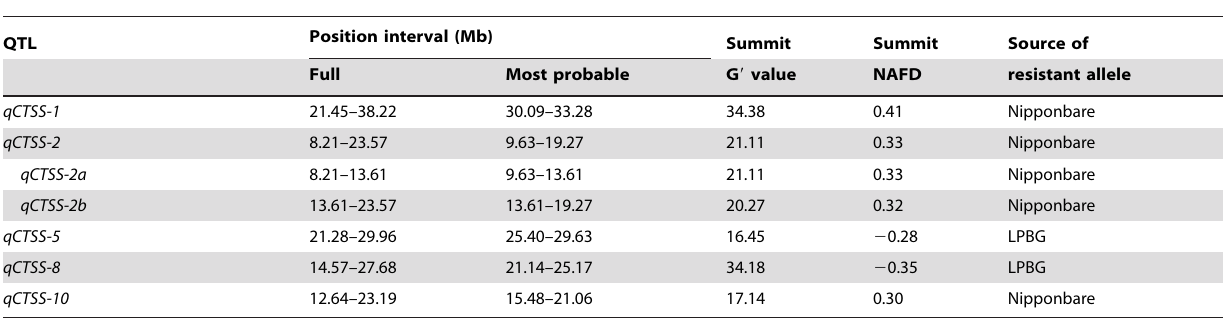
Table 3. QTLs conferring cold tolerance at seedling stage in rice mapped in this